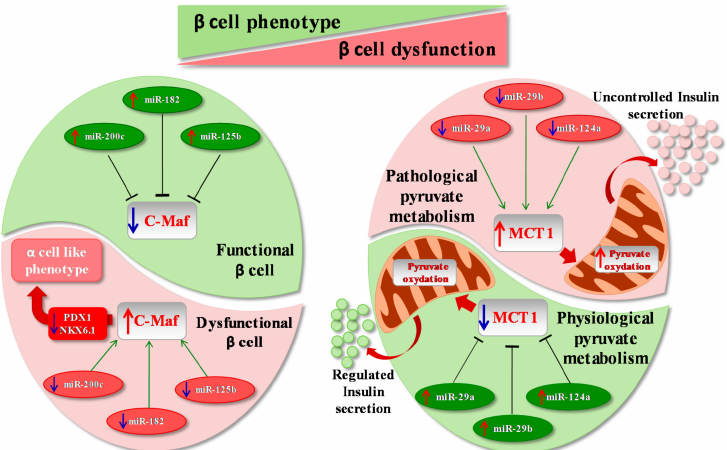
Figure 1. MicroRNAs and disallowed genes. The inhibition of disallowed genes exerted by several microRNAs (miRNAs) is essential in order to maintain functional β cell identity. (Left panel) Indeed, for instance, physiological expression of three miRNAs (miR-200c, miR-182 and miR-125b) is able to inhibit expression of c-Maf , a gene usually absent in mature β cells but enriched in α cells ( green half of cell ). On the contrary, downregulation of miR-200c, miR-182 and miR-125b leads to pathological hyperexpression of c-Maf in β cells, leading to a reduction of essential β cell genes and transcription factors, thus inducing β cells to switch to an α cell-like phenotype ( pink half of cell ). Importantly, loss of β cell identity also leads to β cell dysfunction and metabolic alterations. (Right panel) A particular disallowed gene, MCT1 , physiologically inhibited by miR-29a/b and miR-124a, is involved in the regulation of insulin secretion through the modulation of pyruvate metabolism ( green half of cell ). In addition, reduction of the previously cited miRNAs leads to MCT1 hyperexpression in β cell, thus inducing pyruvate oxidation and uncontrolled insulin secretion ( pink half of the cell